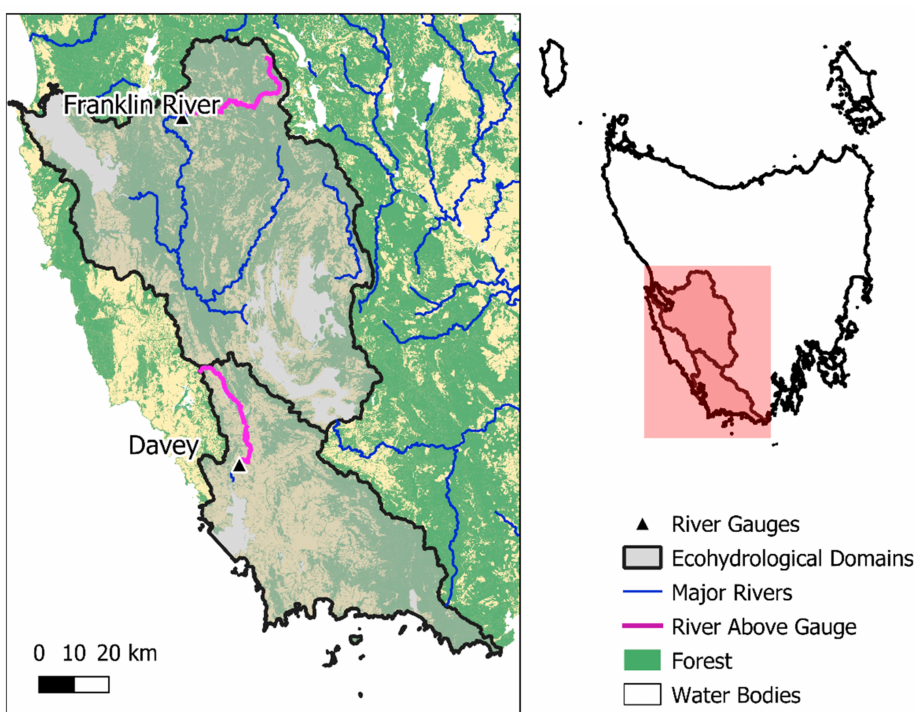
Figure 1. Map of study location in Tasmania, showing location of Franklin and Davey river gauges, surrounding eco-hydrological domains other major rivers, as well as extent of forest